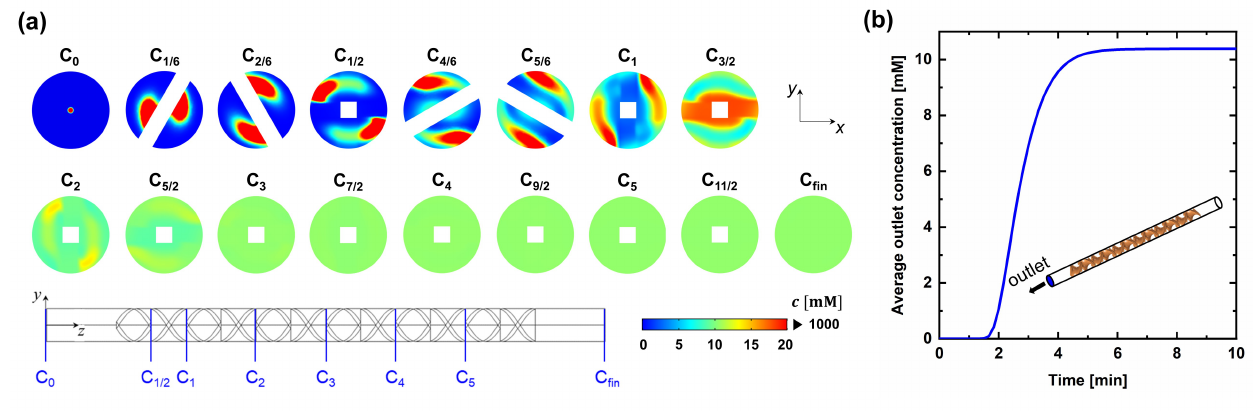
Figure 7. Concentration distribution in the static mixer. ( a ) Concentration distribution ( C n ) at the cross-section of the n-th mixing period. When c ≥ 20 mM, the color of the contour is represented in red because the maximum concentration is much larger than the concentration at the mixed state. ( b ) The RTD curve in the static mixer when the concentration at the tip of the syringe needle is kept constant at 1